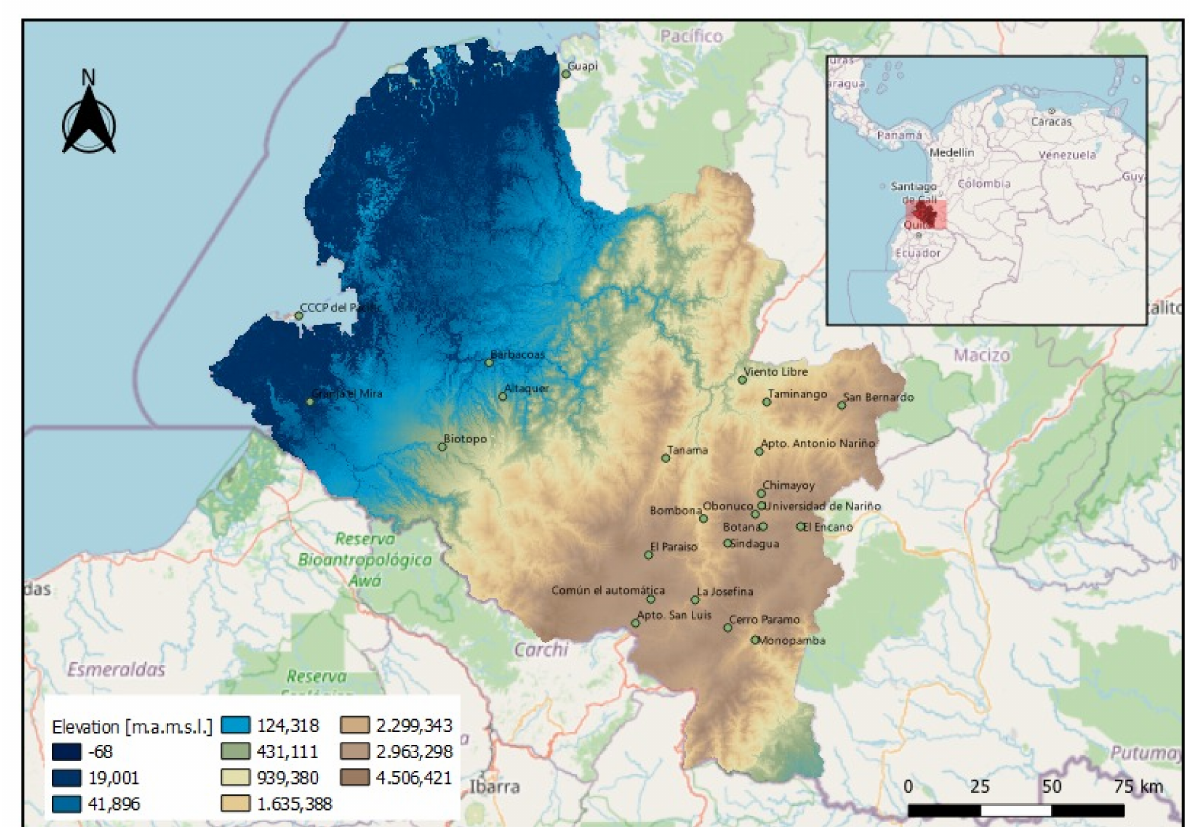
Figure 1. Automatic and conventional weather stations in Nariño. Source: made by the authors with information from